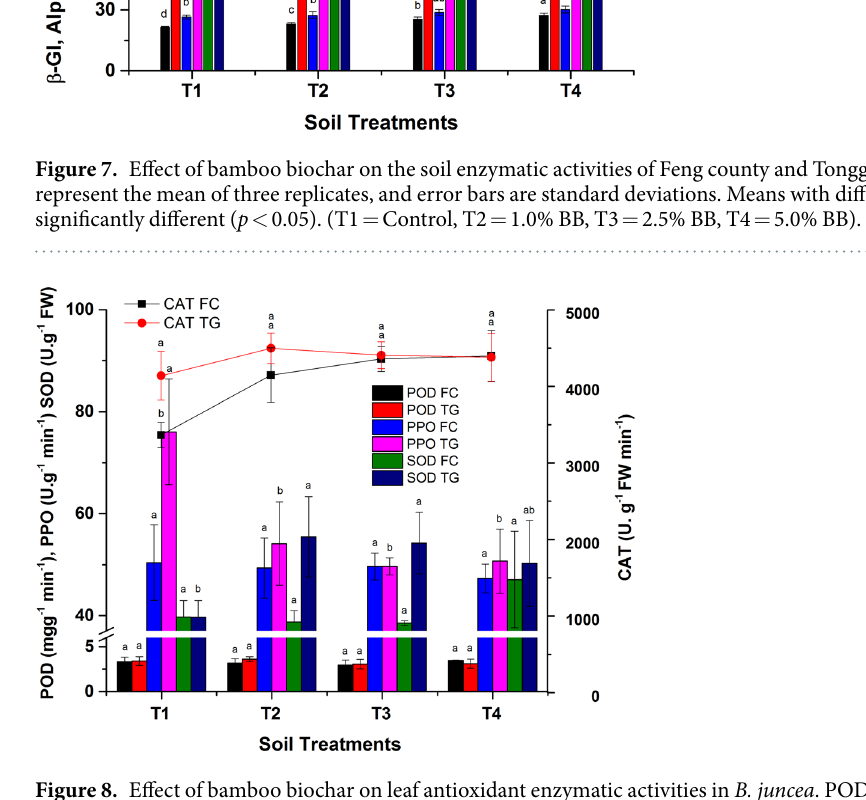
Figure 8. Effect of bamboo biochar on leaf antioxidant enzymatic activities in B. juncea . POD was expressed in mg g − 1 min − 1 , PPO in U. g − 1 min − 1 , CAT in U. g − 1 FW min − 1 and SOD U g − 1 FW. The data represent the mean of three replicates, and error bars are standard deviations. Means with different letters are significantly different ( p < 0.05). (T1 = Control, T2 = 1.0% BB, T3 = 2.5% BB, T4 = 5.0%